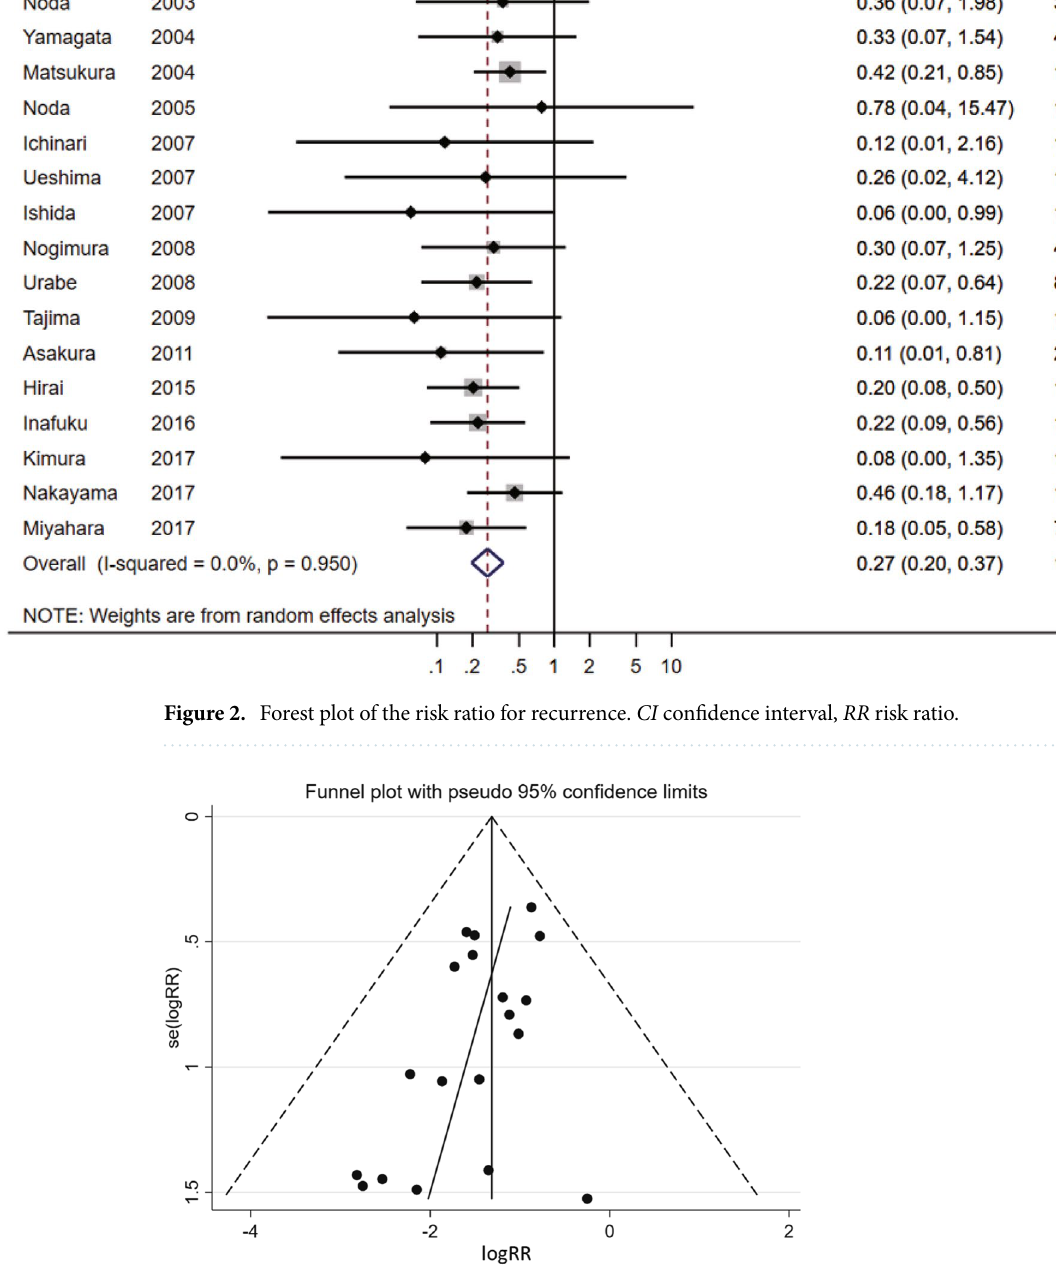
Figure 3. Funnel plot of the included studies. The asymmetrical plot indicates publication bias. RR risk